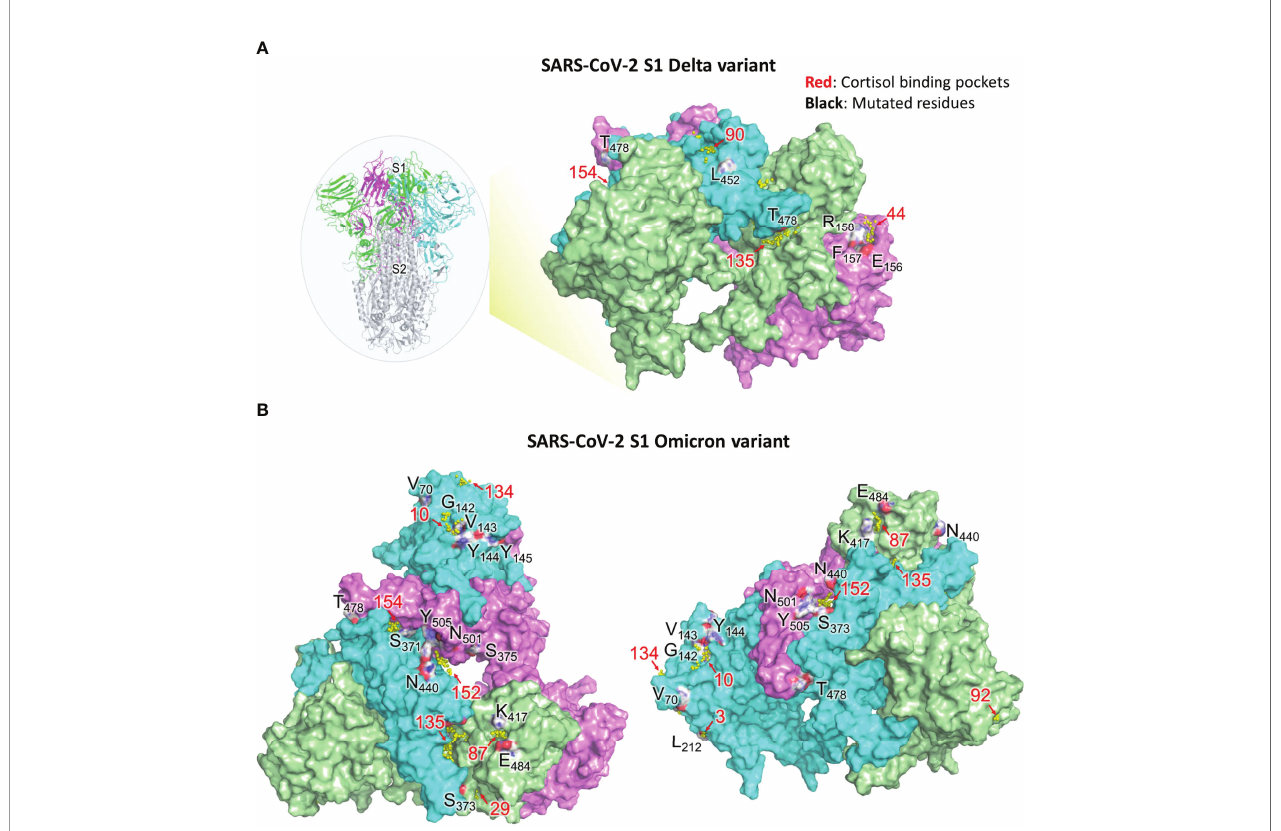
FIGURE 6 | Visual representation of SARS-CoV-2 S1 residues mutated in Delta and Omicron variants and their associated cortisol binding pockets (refer Tables 5 , 6 ). (A) Residues of SARS-CoV-2 S1 protein (WT) that are deleted or mutated in the Delta variant along with neighboring glucocorticoid binding pockets. Insert on the left, shows the spike protein of SARS-CoV-2. S1 trimer (three monomers are colored as green, cyan and magenta) and S2 trimer (grey) are shown. The residues, which are not proximal to any binding pocket, are not shown. Pockets (yellow spheres) and their respective numbers are shown. Pocket 154 is buried in between RBD domains of chain B and C The residues are colored based on the element (red for oxygen, blue for nitrogen, white for carbon). (B) Residues of SARS-CoV-2 S1 protein (WT) that are deleted or mutated in the Omicron variant along with neighboring glucocorticoid binding pockets. Pockets with their respective numbers are shown as yellow spheres. Chain A (green), chain B (cyan) and chain C (pink) of S1 are shown. Left: Top view of S1 in wild type SARS-CoV-2; Right: Rotated view of S1 focusing on chain B The residues are colored based on the element (red for oxygen, blue for nitrogen, white for carbon). Binding pockets are in red and mutated residues in